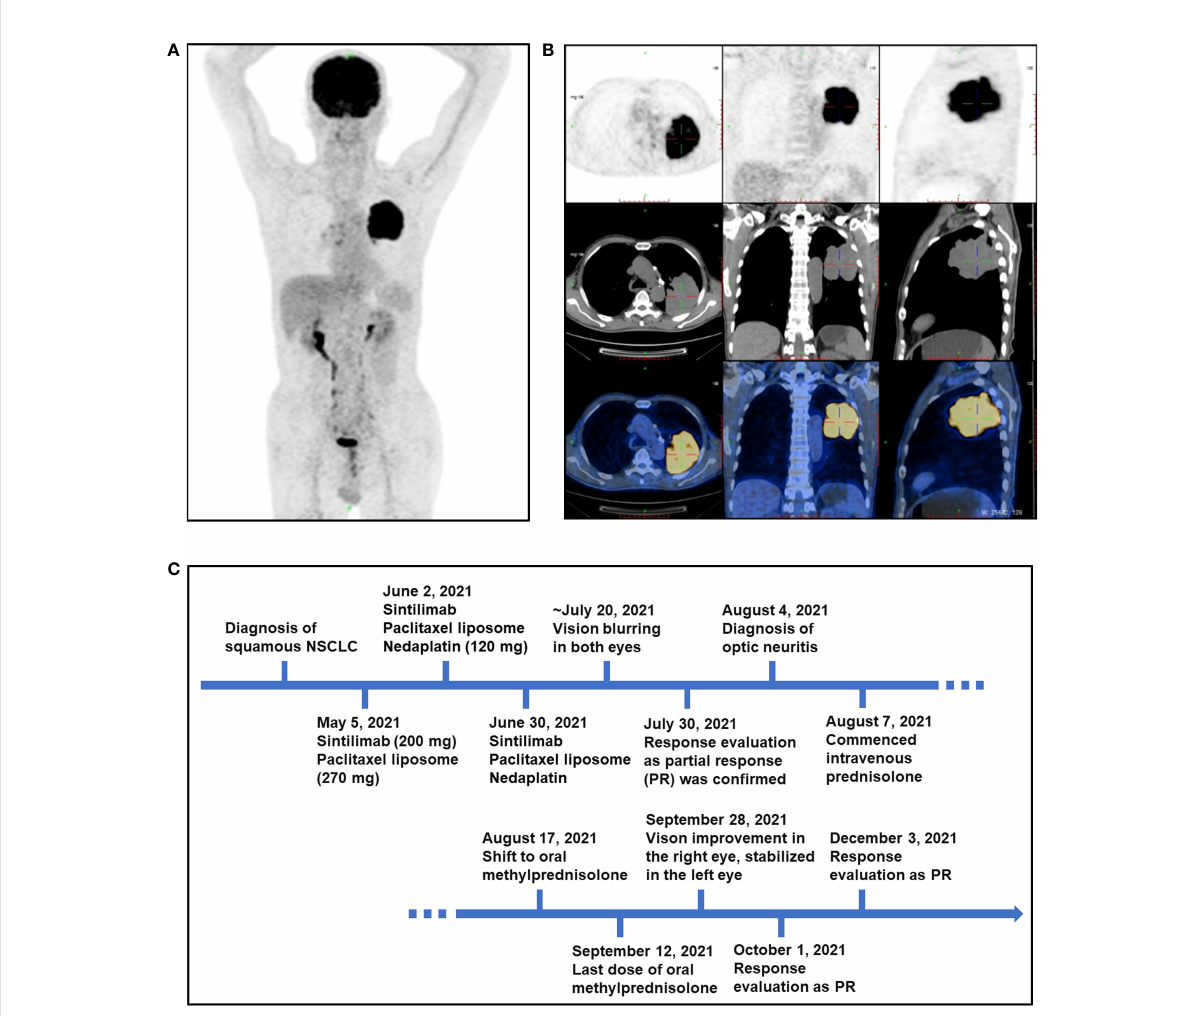
FIGURE 1 PET-CT scan of the patient at baseline and an outlined timeline of his treatment and adverse events. (A, B) Representative images of PET-CT scan of the patient at baseline on 5 May 2021. (C) The schematic timeline for the patient, from diagnosis to resolution of optic neuropathy (not to